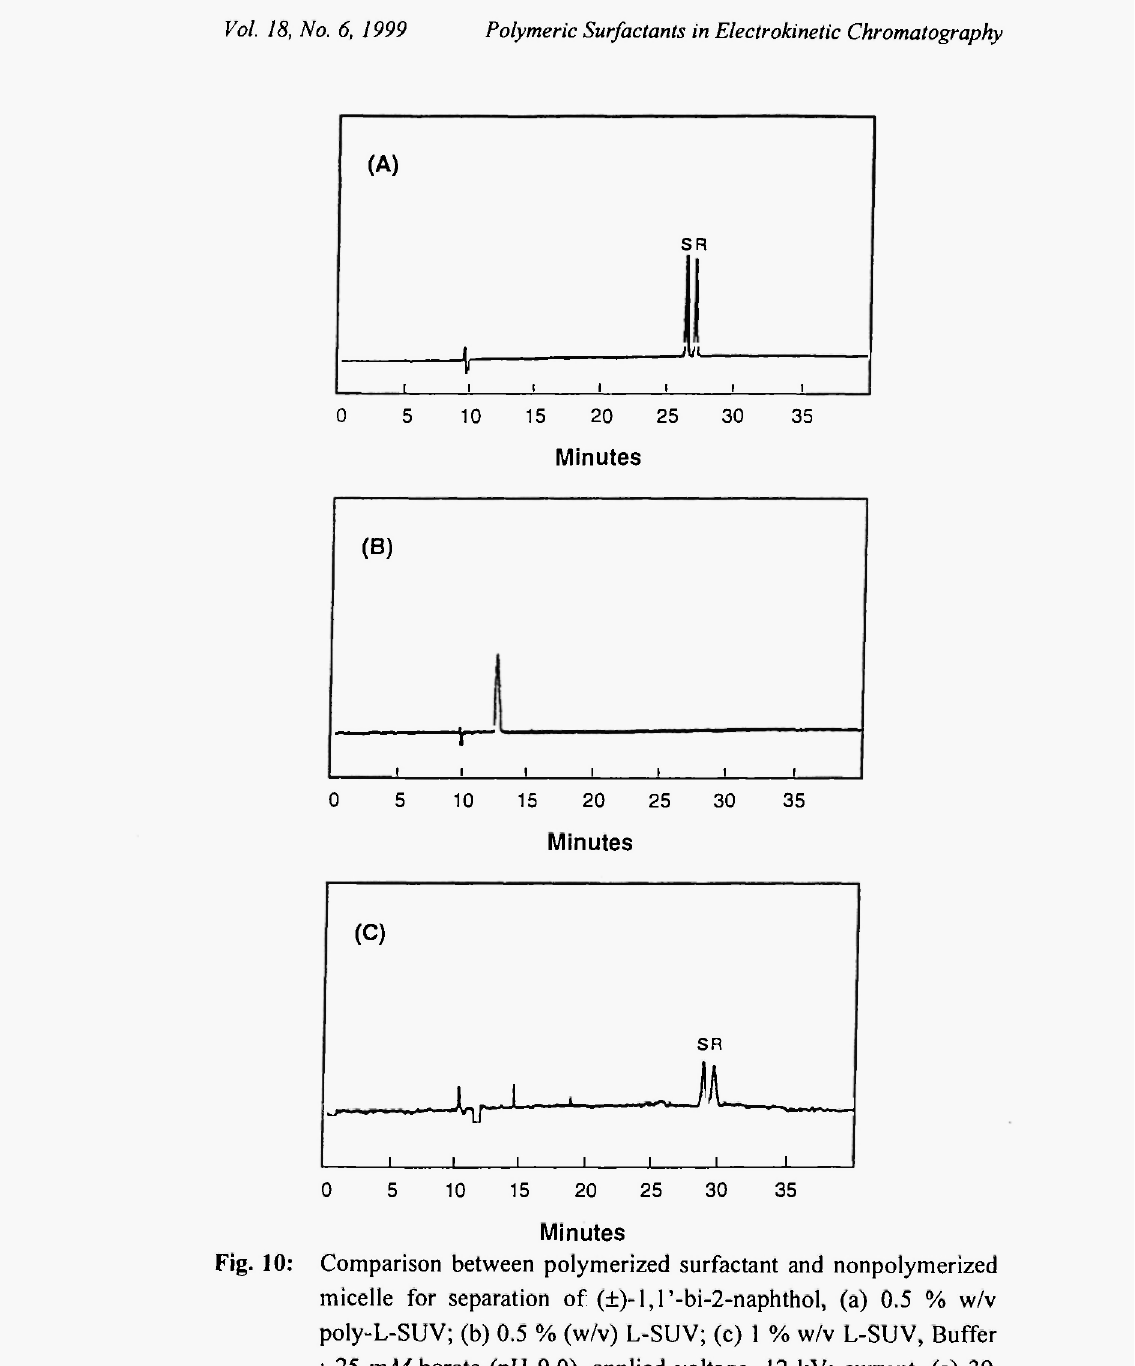
Fig. 10: Comparison between polymerized surfactant and nonpolymerized micelle for separation of (±)-l,l'-bi-2-naphthol, (a) 0.5 % w/v poly-L-SUV; (b) 0.5 % (w/v) L -SUV; (c) 1 % w/v L-SUV, Buffer : 25 mM borate (pH 9.0), applied voltage, 12 kV; current, (a) 39 μΑ, (b) 40 μ A, (c) 51 μΑ; UV detection at 290 nm. From /30/ with